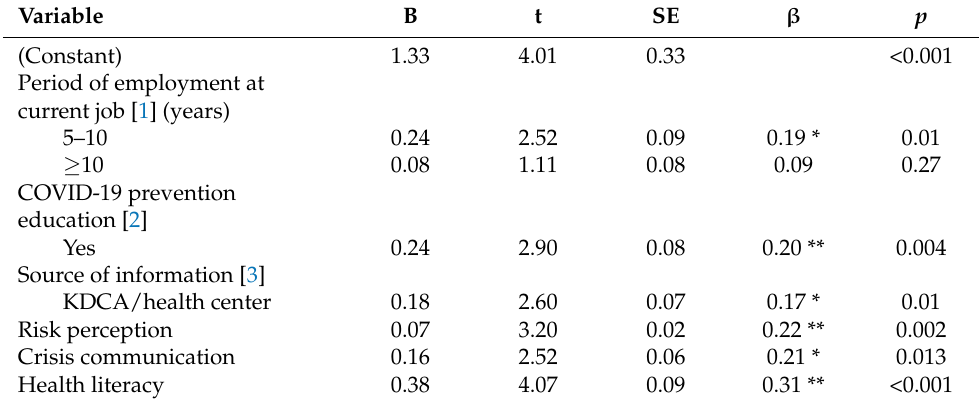
Table 6. Influencing factors of COVID-19 infection prevention behaviors (N =